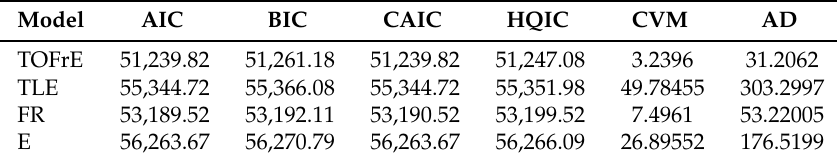
Table 14 indicates the values of the considered criteria of fitness of the models for Data set III. Table 14. Numerical measures of fitness of the models for Data set